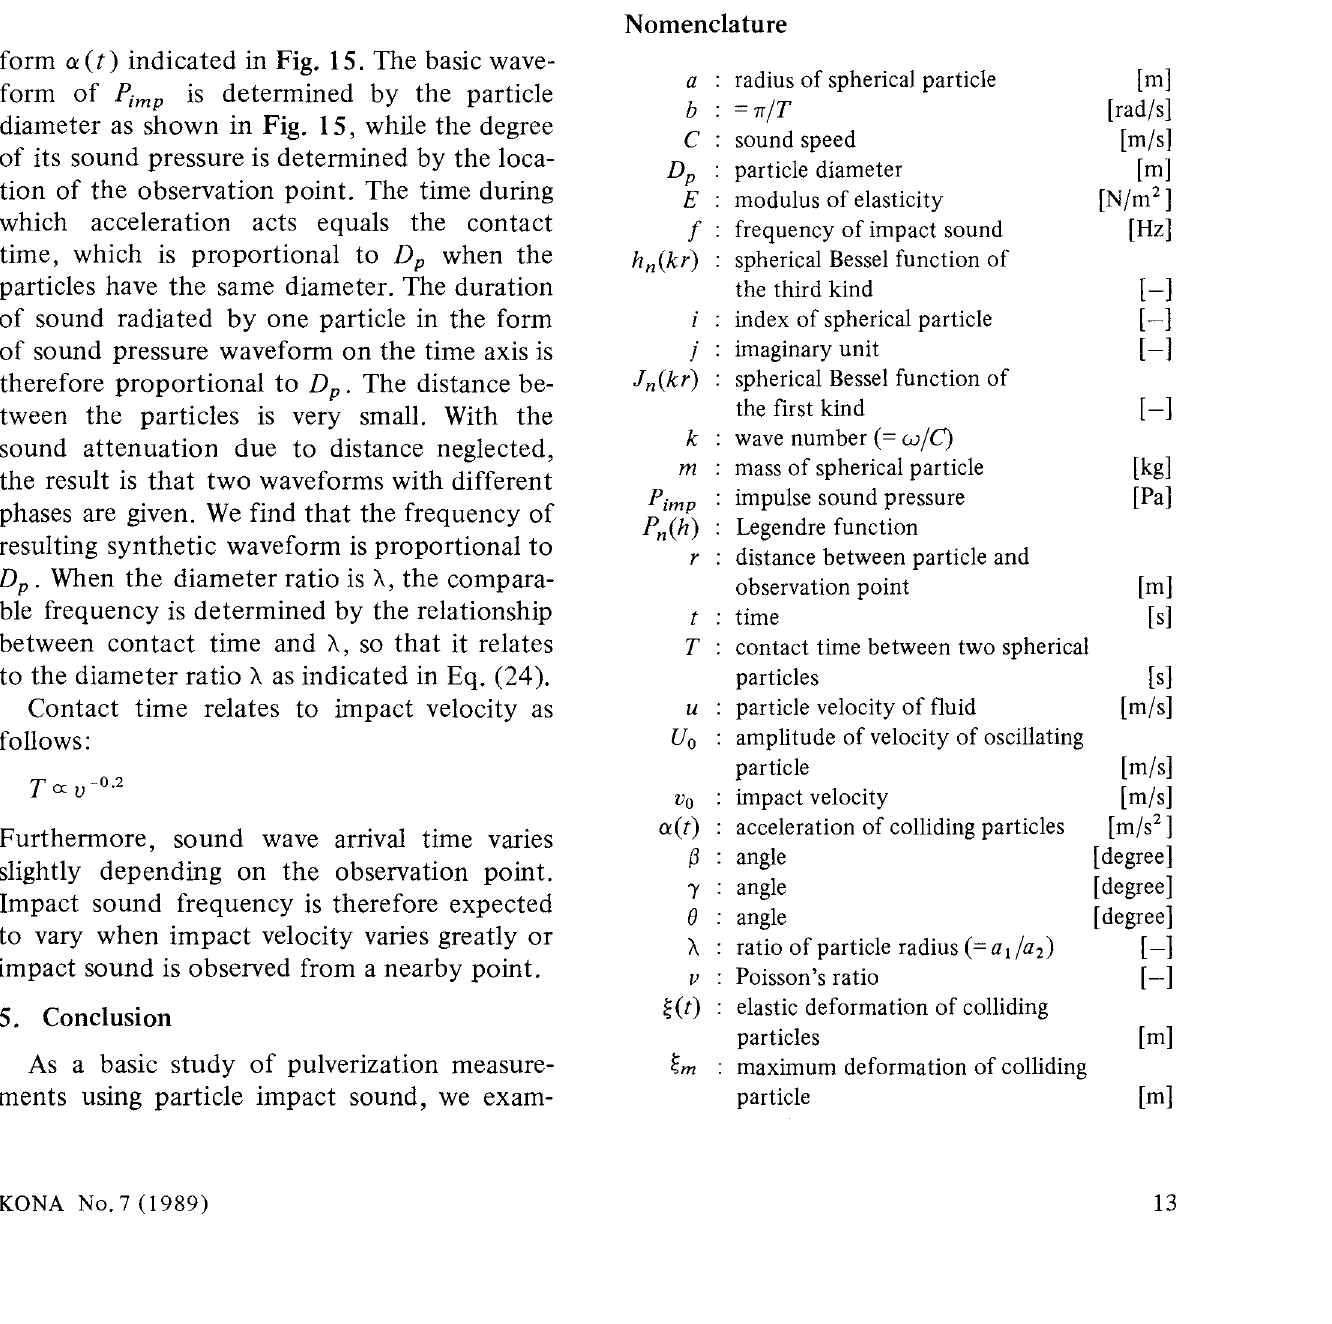
Fig. 15 Impulse sound pressure